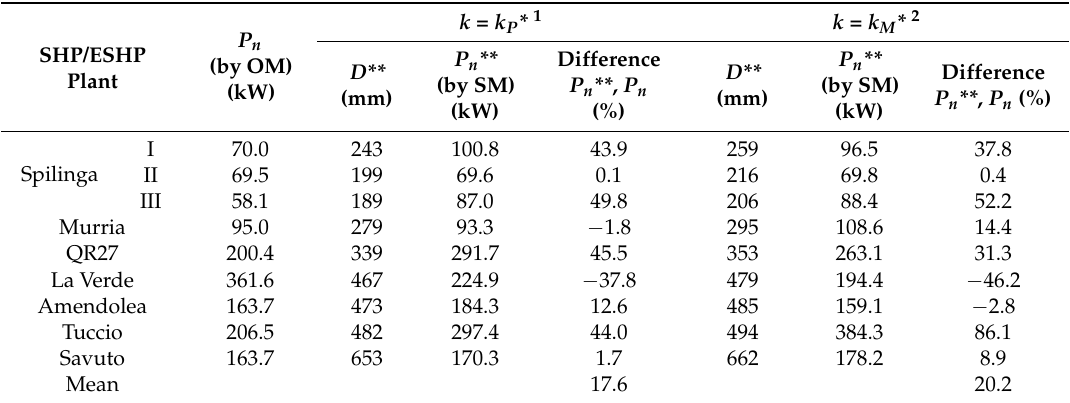
Table 5. Differences between the original and simplified methods OM and SM in estimating the net electrical power ( P n ) of SHP plants in seven irrigation systems of Calabria (Southern Italy).